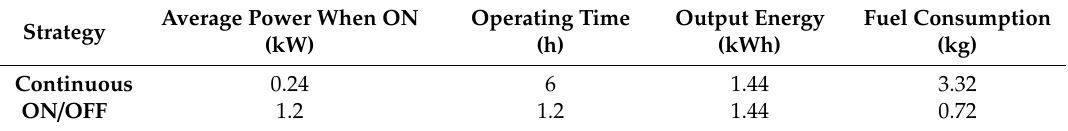
Figure 8. Experimental setup. ( a ) Overall view. ( b ) The SCS. Table 1. Experimental results of applying ON / OFF strategy versus continuous operation.